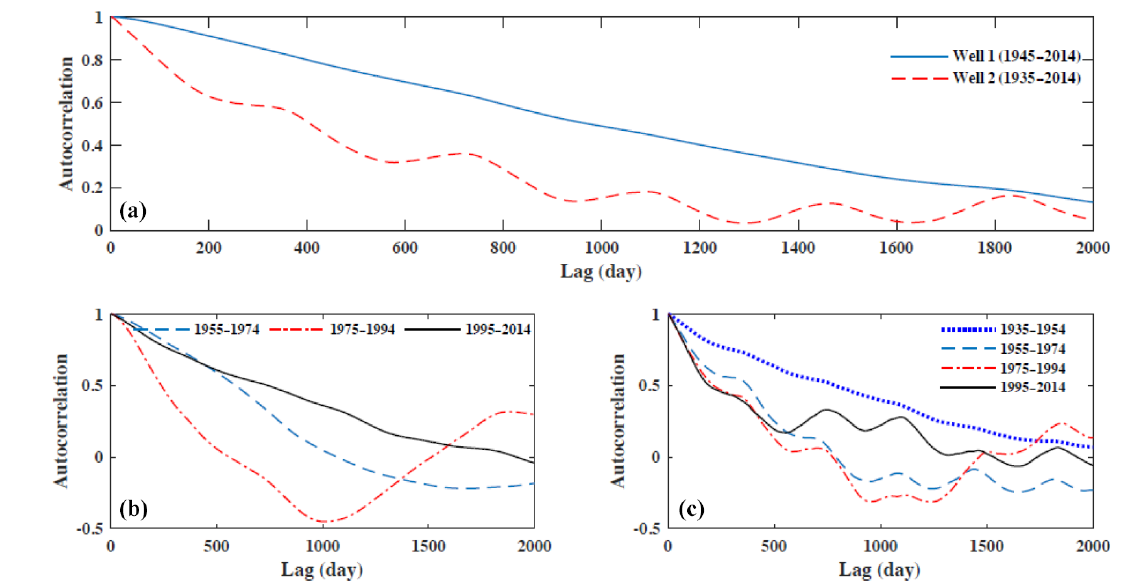
Figure 2. Autocorrelation function (ACF) for all groundwater level datasets (a) ; ACF at each 20-year interval for Well 1 (b) and Well 2 (c) .